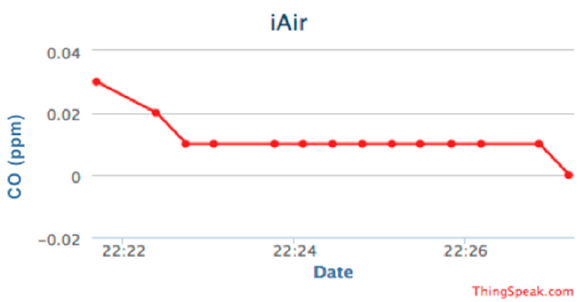
Figure 5. CO concentration (ppm); data obtained in the tests performed.